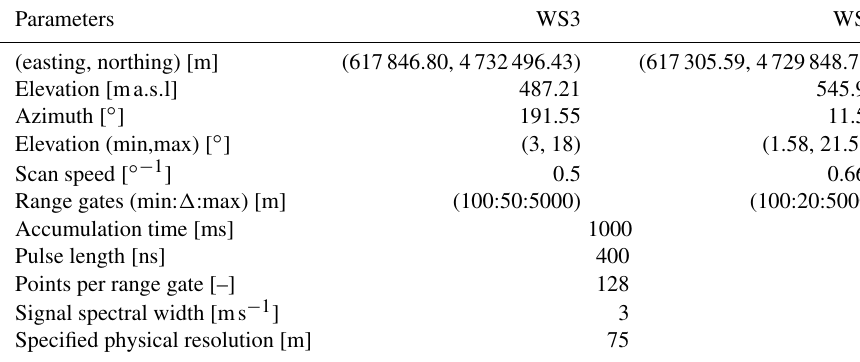
Table A1. WindScanner position and configuration for the transect RHI